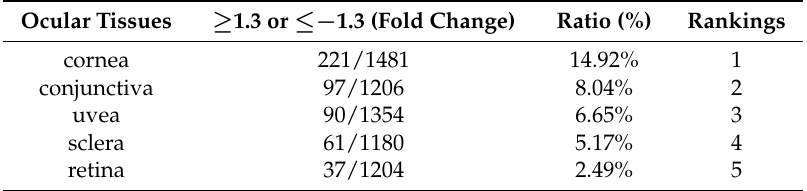
Figure 6. Percentage of total cellular proteins identified by 2D-DIGE/matrix-assisted laser desorption/ionization time-of-flight mass spectrometry (MALDI-TOF MS) for ( A ) cornea; ( B ) conjunctiva; ( C ) uvea; ( D ) sclera; and ( E ) retina according to their biological functions. Table 1. Order of protein expression alterations (i.e., cornea, conjunctiva, uvea, sclera, and retina) according to the ratio of protein expression alterations.